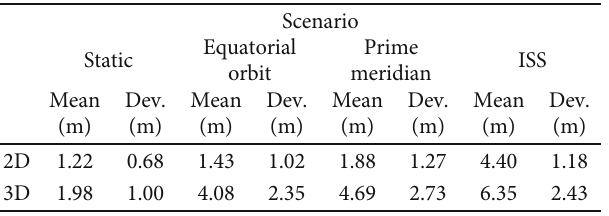
Table 3: Mean values and standard deviations of piNAV position errors.